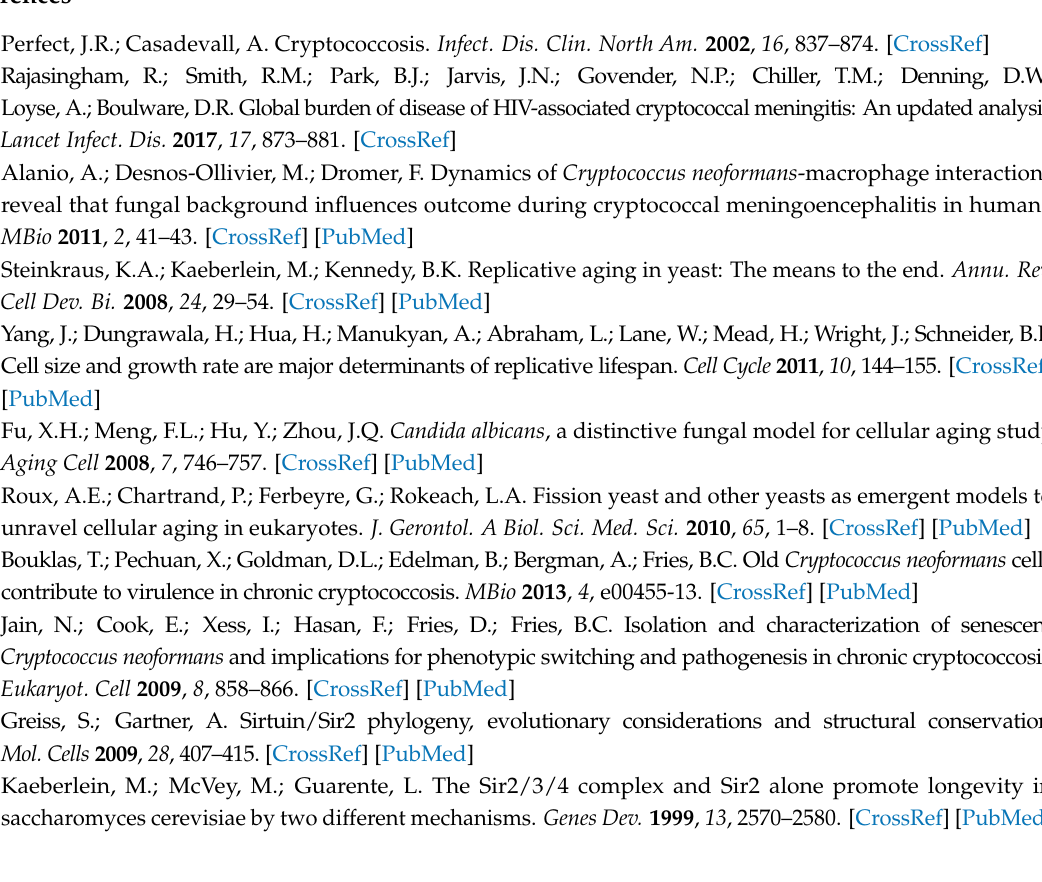
Figure S1: Confirmation of the sir2 ∆ mutant; Table S1: Strains used in the study; Table S2: List of primers used in the construction of the sir2 ∆ mutant; Table S3: List of primers used to measure mRNA expression of select genes; Table S4: Comparison of the sir2 ∆ phenotypes in the H99 and RC2 strains; Table S5: List of differentially regulated genes in RC2- sir2 ∆ compared to RC2 cells grown in calorie restricted